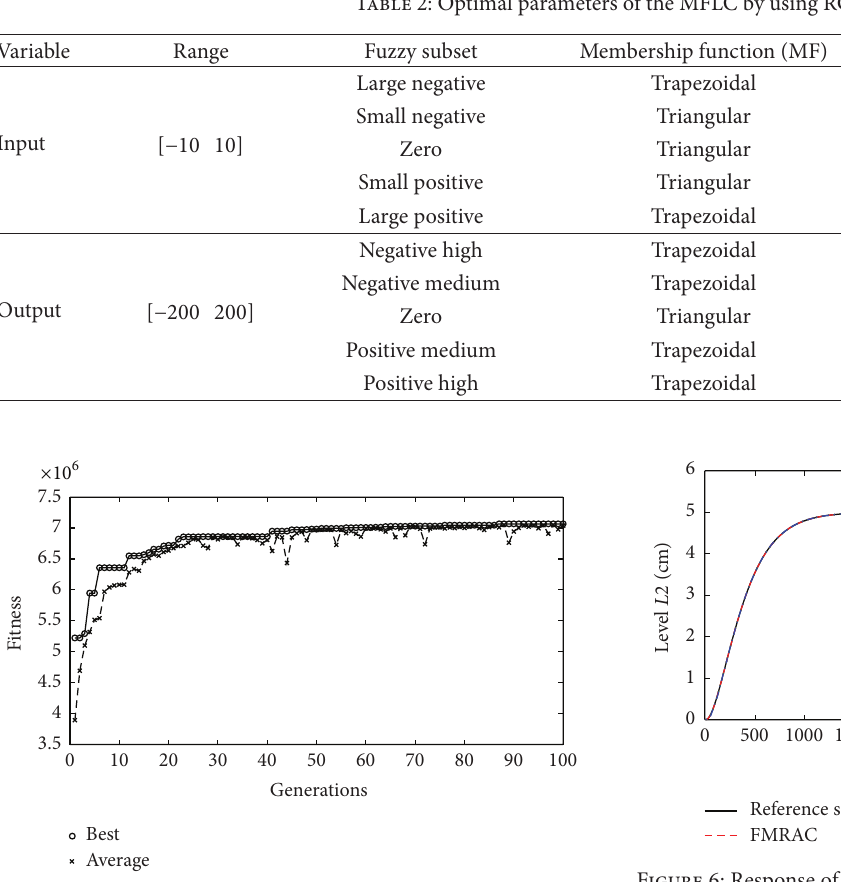
Table 3. Rise time 𝑇 𝑟 , settling time 𝑇 𝑠 , and mean square error (MSE) are the three performance indices considered in the paper. In this context, 𝑇 𝑠 is the time it takes for the process output 𝑦 to reach within ± 5% of its final value and stay there. Rise time 𝑇 𝑟 is the time it takes for the plant output 𝑦 to reach 90% of the final value from 10% of the same. The main objective is to make the process follow the reference model as closely as possible with minimal